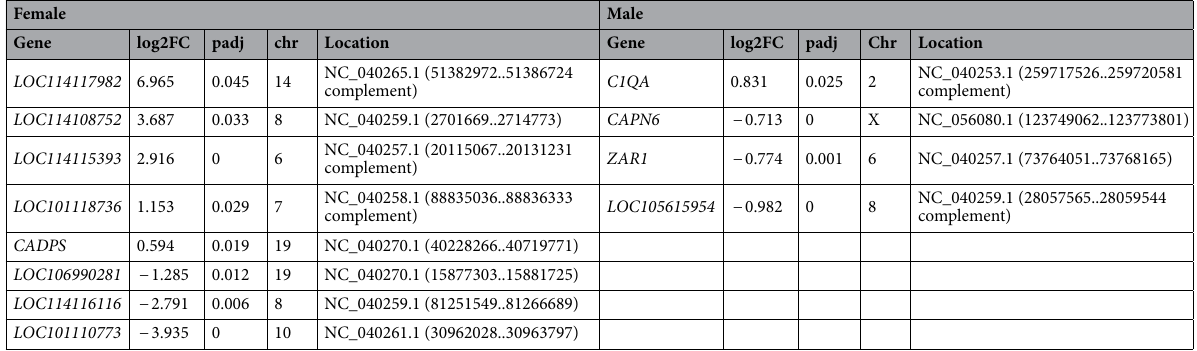
Table 4. Gestational T modulated coding RNA in the female and male fetal LV tissue. Genes highly modulated in either the female or male fetal LV tissue with adjusted p-value (padj) < 0.05 and absolute log2 fold change(log2FC) > 0.5 are represented. The top genes sorted by absolute magnitude are represented with their direction of